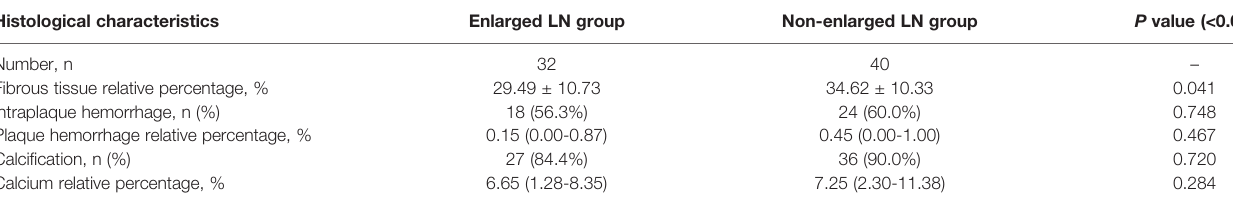
TABLE 2 | Histological Characteristics of Plaques.